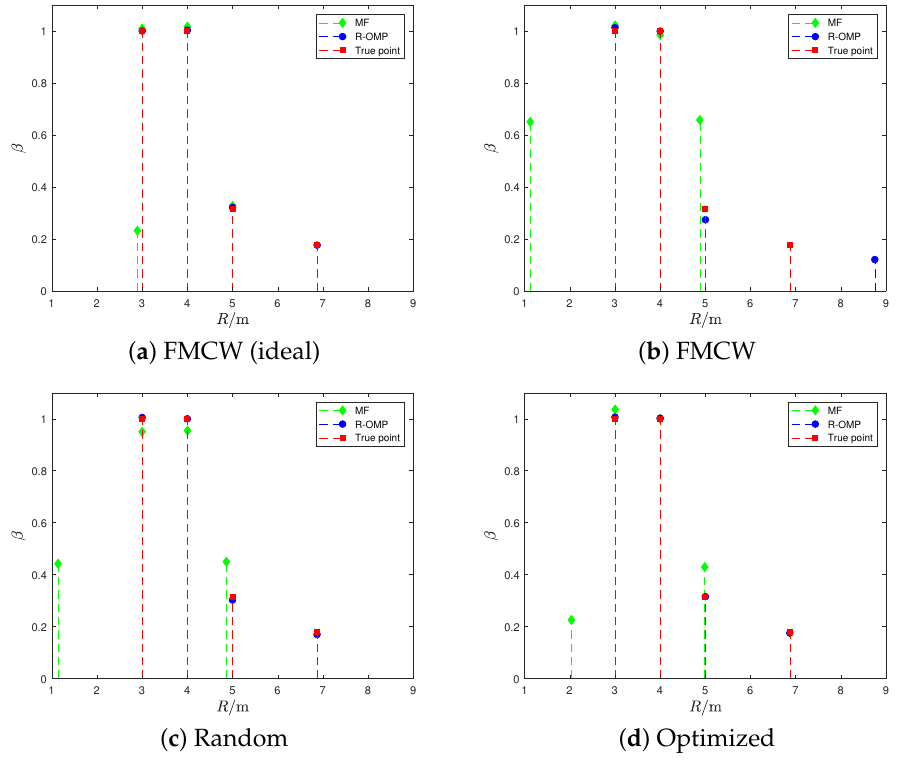
Figure 11. Recovery result of range